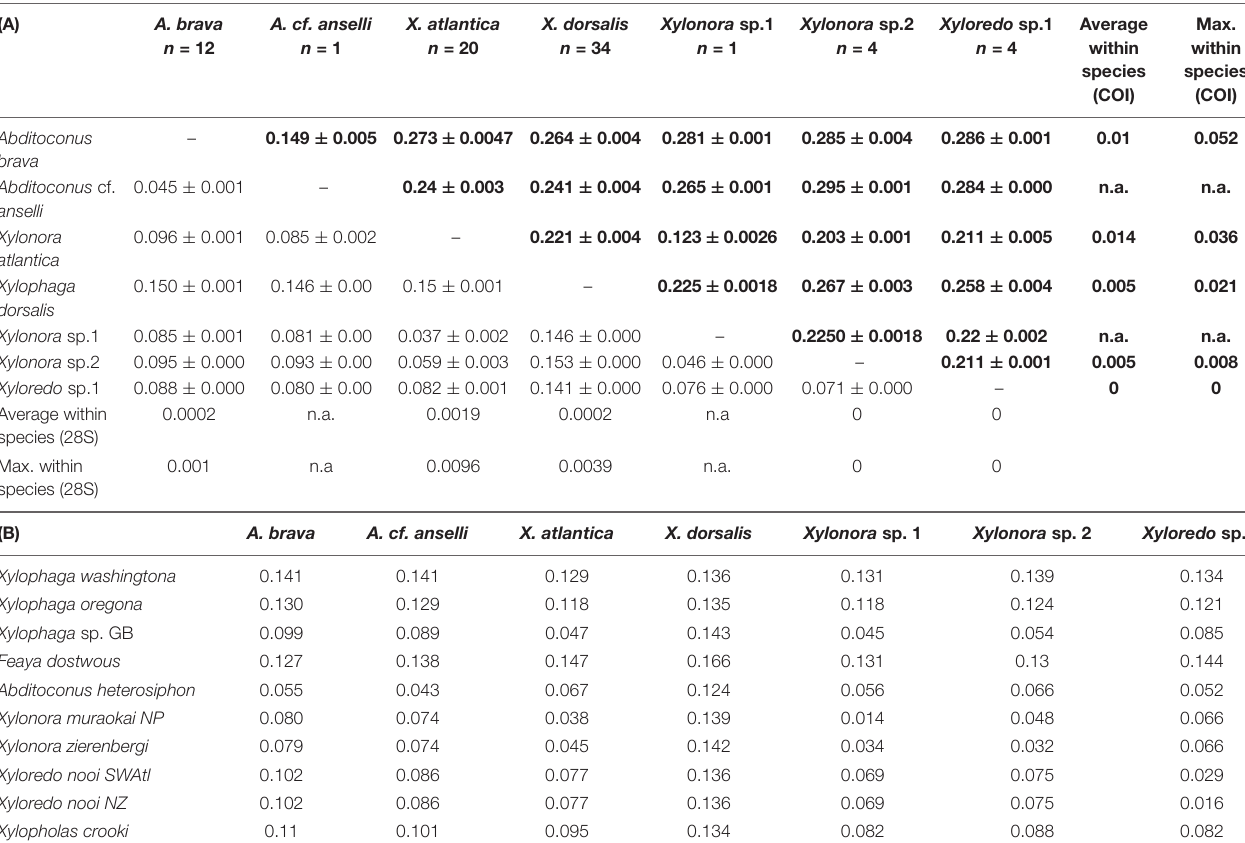
TABLE 3 | Pairwise genetic divergence for the species of